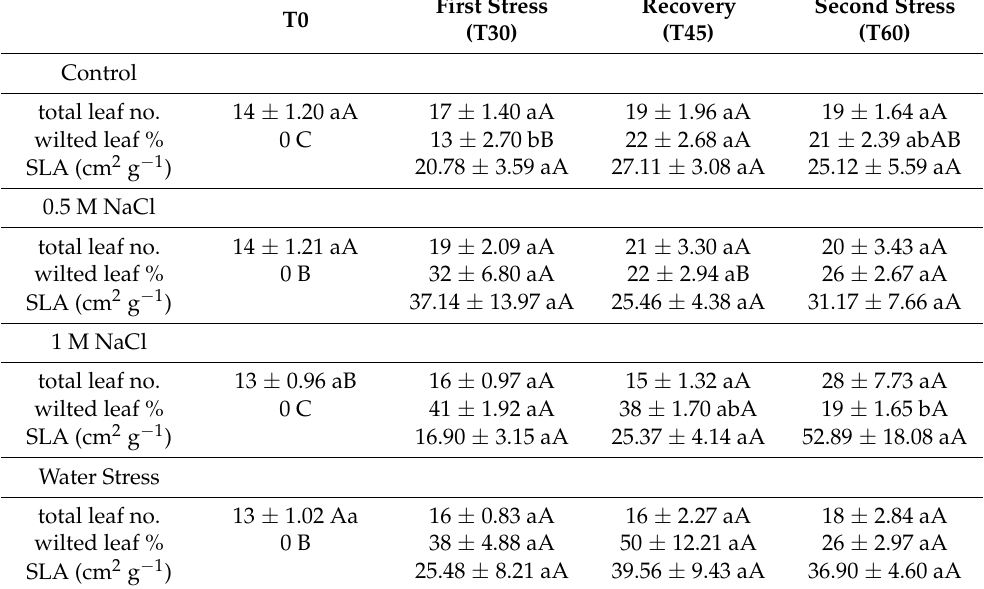
Table 1. Total leaf number (LN), wilted leaf percentage (%WL), and specific leaf area (SLA) of Limonium angustebracteatum plants, measured at the beginning of the experiment (T0), and after 30 days of stress treatments (T30), 15 days of watering with non-saline water (T45), and another 15 days of stress (T60). Different lowercase letters indicate significant differences between treatments (Control, 0.5 M NaCl, 1 M NaCl, and Water stress) for each sampling time, at p ≤ 0.05. Different uppercase letters indicate significant differences between the sampling times (T0, First stress, Recovery, and Second stress) for each treatment, at p ≤ 0.05. Data are shown as mean ± standard error (n = 4). First Stress Recovery T0 (T30) (T45) (T60) Control total leaf